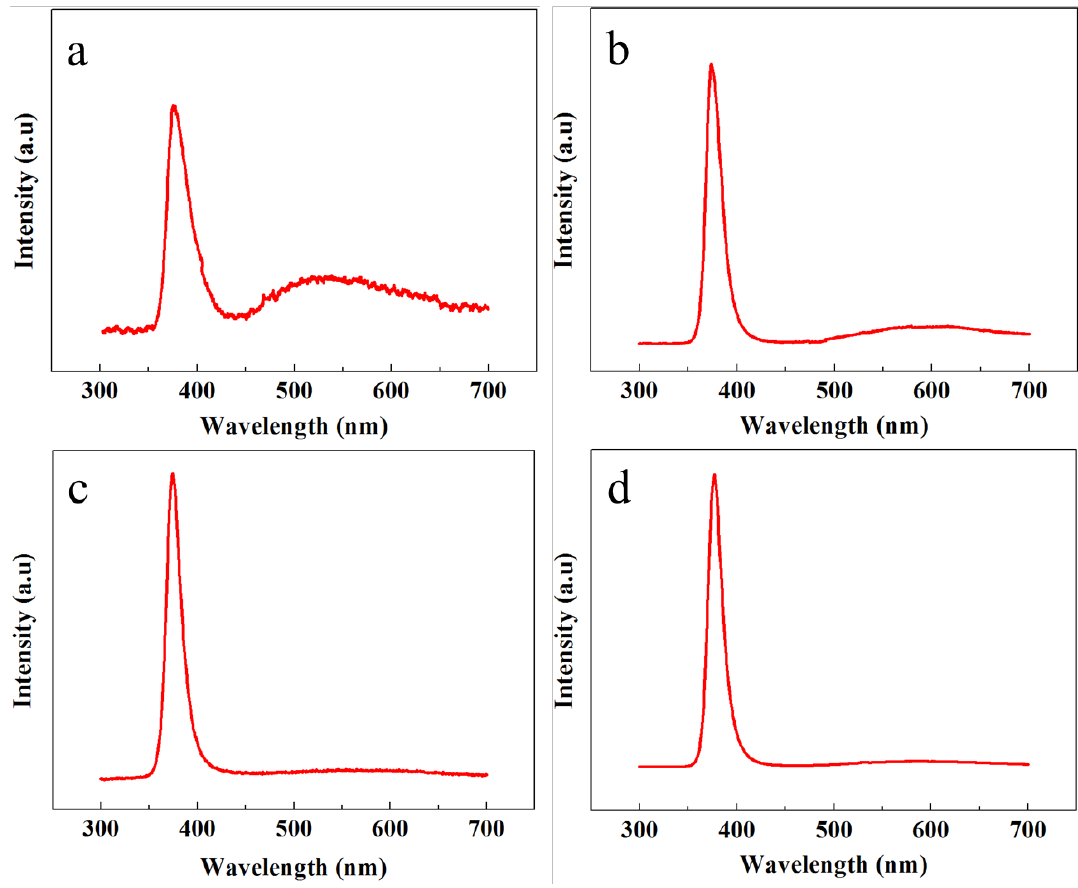
Figure 4. PL spectra of ZNRs grown with ( a ) ACG, ( b ) Ga-doped ACG, ( c ) OPT-ACG, and ( d ) MAG methods.